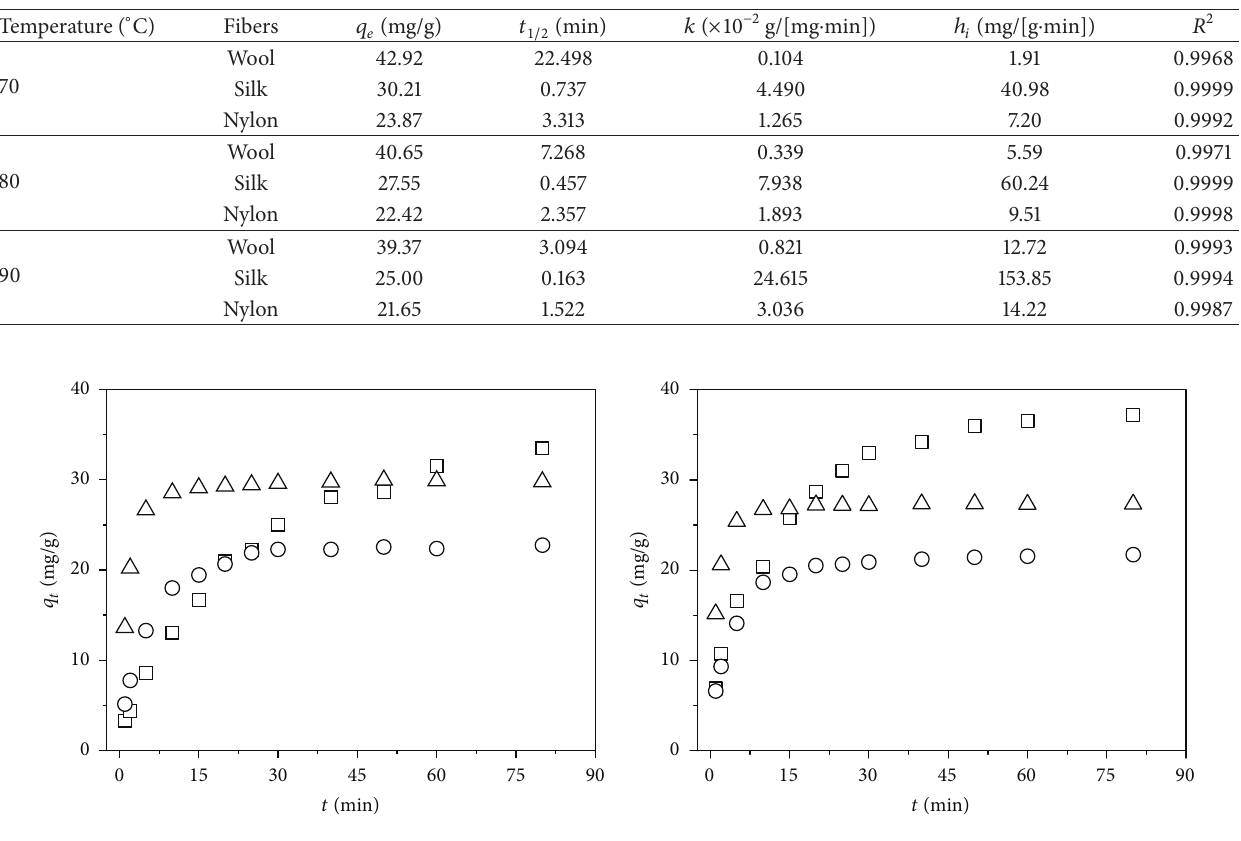
Table 1: Kinetic parameters for the adsorption of lac dyes on wool, silk, and nylon.